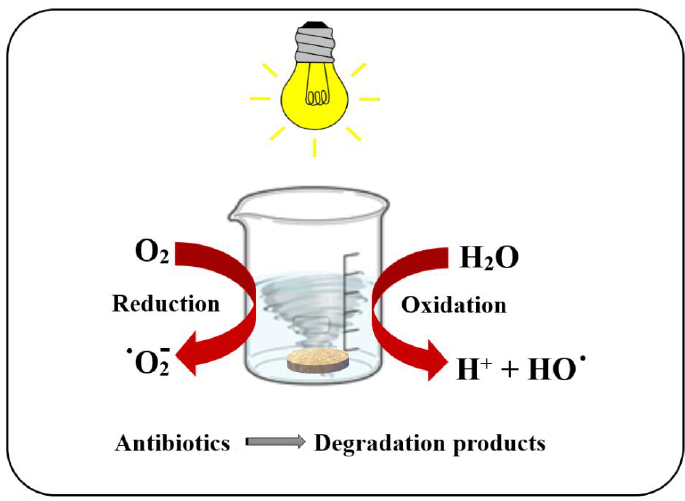
Figure 12. The schematic setup for the photocatalytic test.